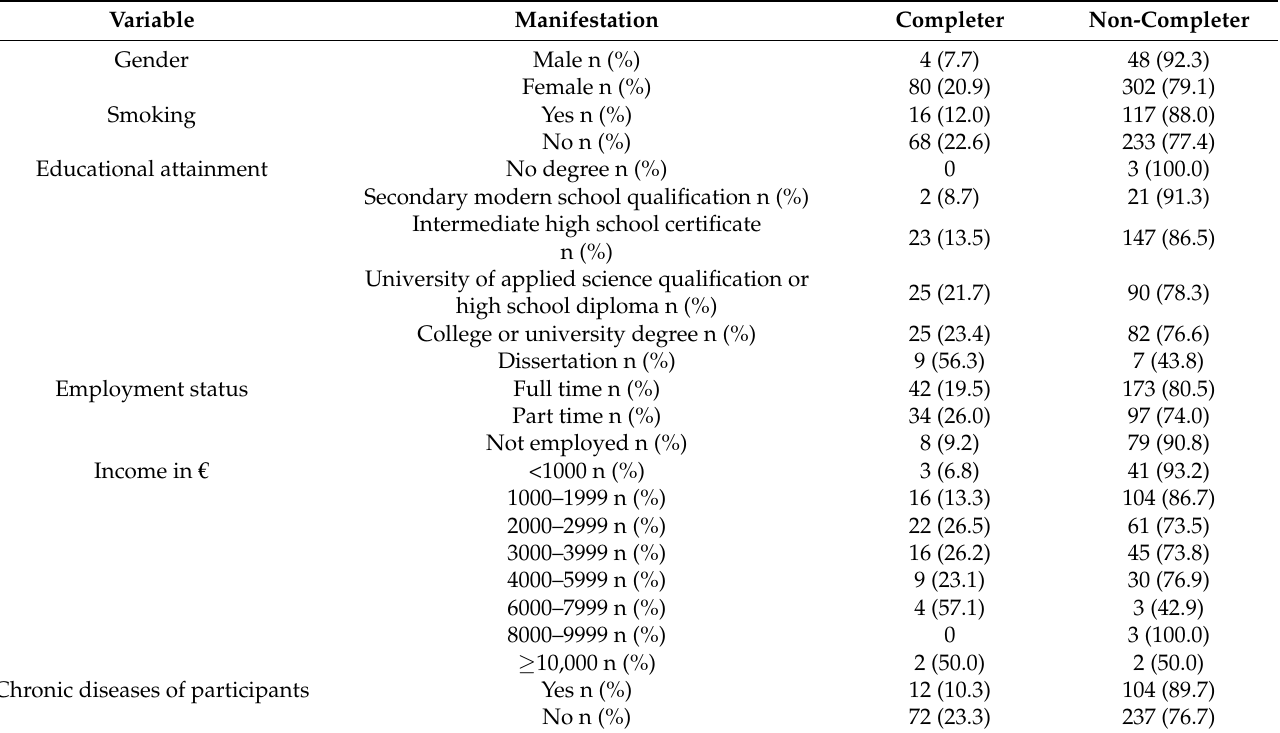
Table 5. Sociodemographic status of completers vs.